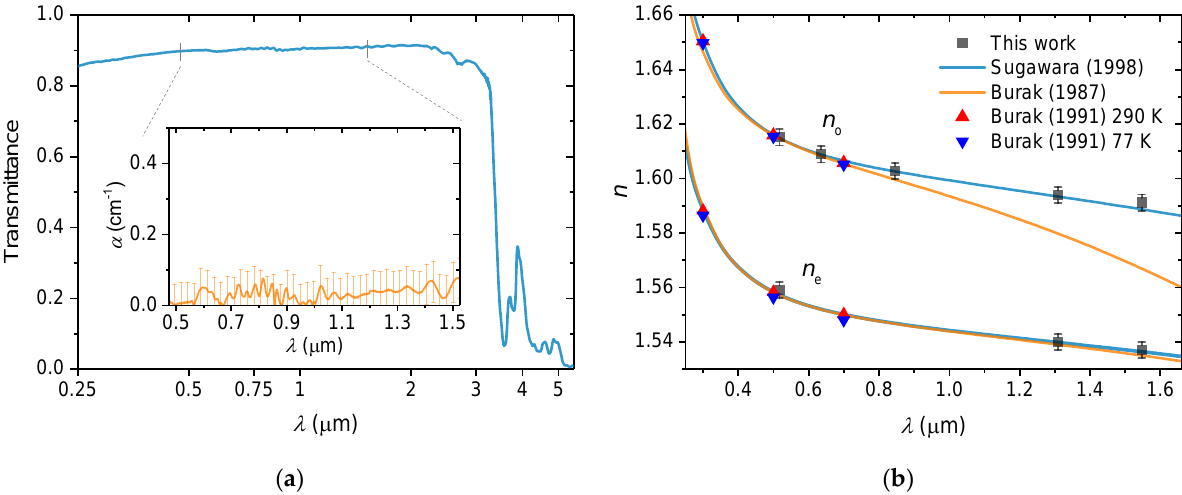
Figure 1. Optical properties in main transparency window: ( a ) transmittance of LB4 crystal in the visible and infrared regions, measured in non-polarized light; the inset shows an estimate of the absorption coefficient of the sample, taking the dispersion of the reflection coefficient into account. ( b ) Dispersion of the refractive index of the LB4 crystal for ordinary and extraordinary waves at room temperature (if not specified otherwise).